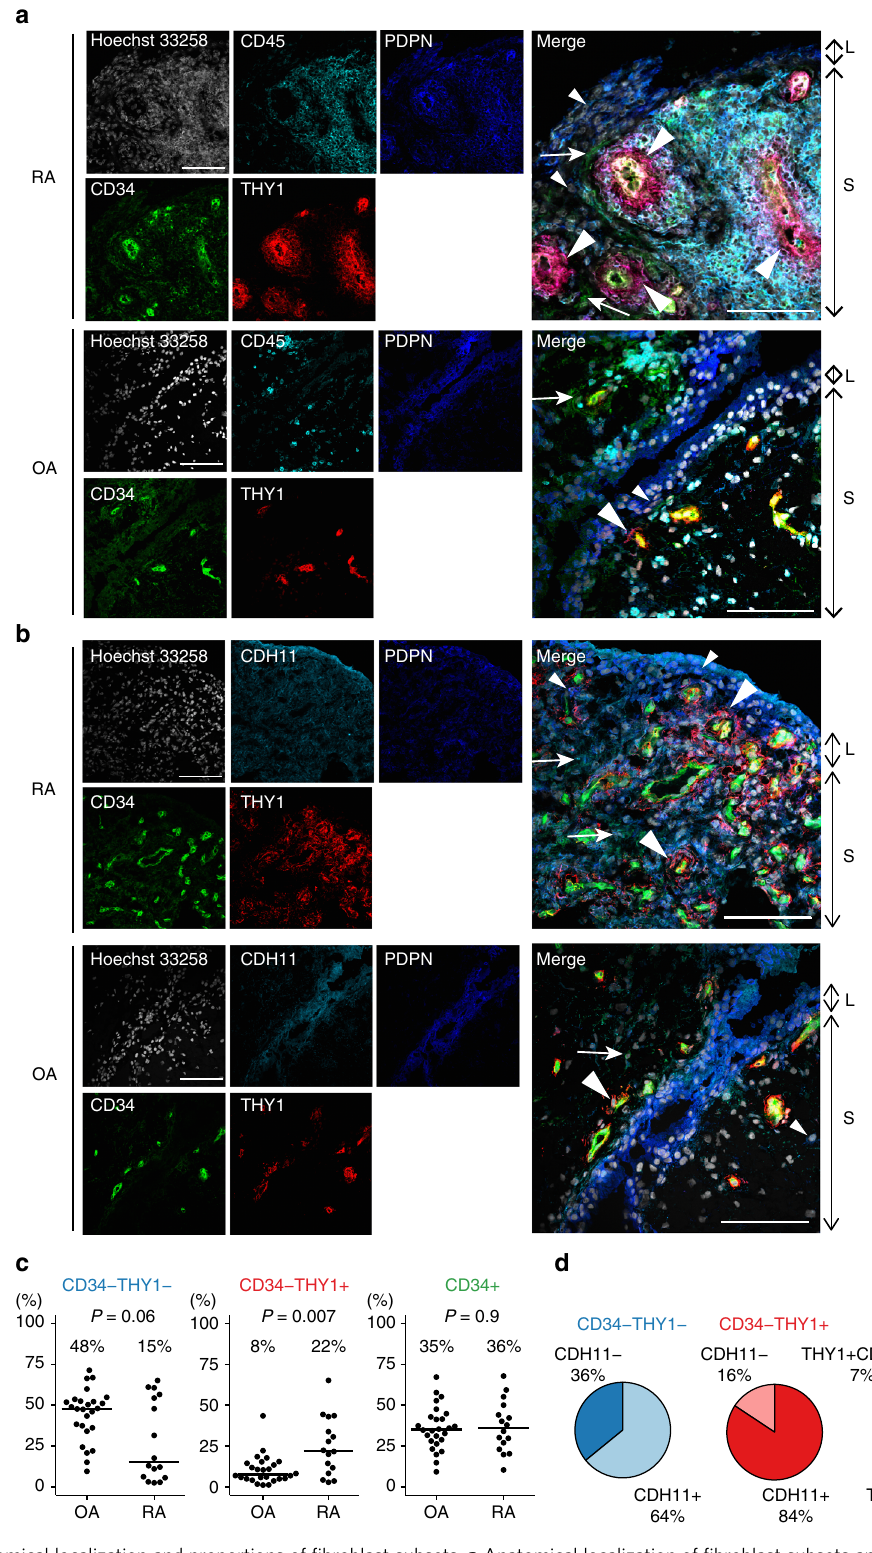
Fig. 3 Anatomical localization and proportions of fi broblast subsets. a Anatomical localization of fi broblast subsets and leukocytes in RA and OA synovial tissue. Hoechst 33258: white, CD45: cyan, PDPN: blue, CD34: green, THY1: red. Small arrowheads: CD34 – THY1 – fi broblasts. Big arrowheads: CD34 – THY1 + fi broblasts. Arrows: CD34 + fi broblasts. Scale = 100 µ m. b Expression of fi broblast subset markers in RA and OA synovial tissue. Hoechst 33258: white, CDH11: cyan, PDPN: blue, CD34: green, THY1: red. c Proportions of fi broblast subsets in synovial tissue in OA ( n = 26) and RA ( n = 16) evaluated by fl ow cytometry. P values from the Wilcoxon's rank-sum test. d Proportions of CDH11 + cells in CD34 – THY1 – fi broblasts, CD34 – THY1 + fi broblasts, and CD34 + fi broblasts. L lining area, S sublining